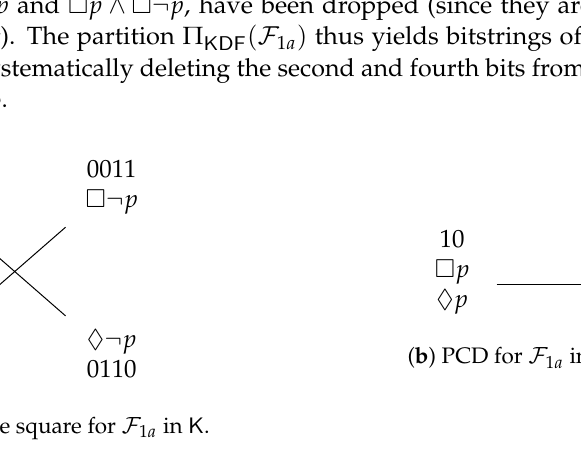
Figure 5. Aristotelian diagrams for F 1 a = { (cid:3) p , ♦ p , (cid:3) ¬ p , ♦ ¬ p } in two normal modal